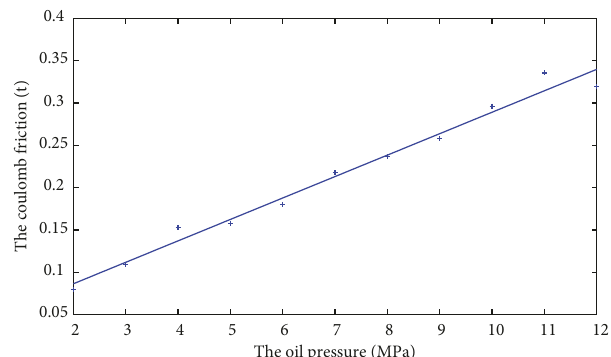
Figure 18: Effect of pressure change on the Coulomb friction.